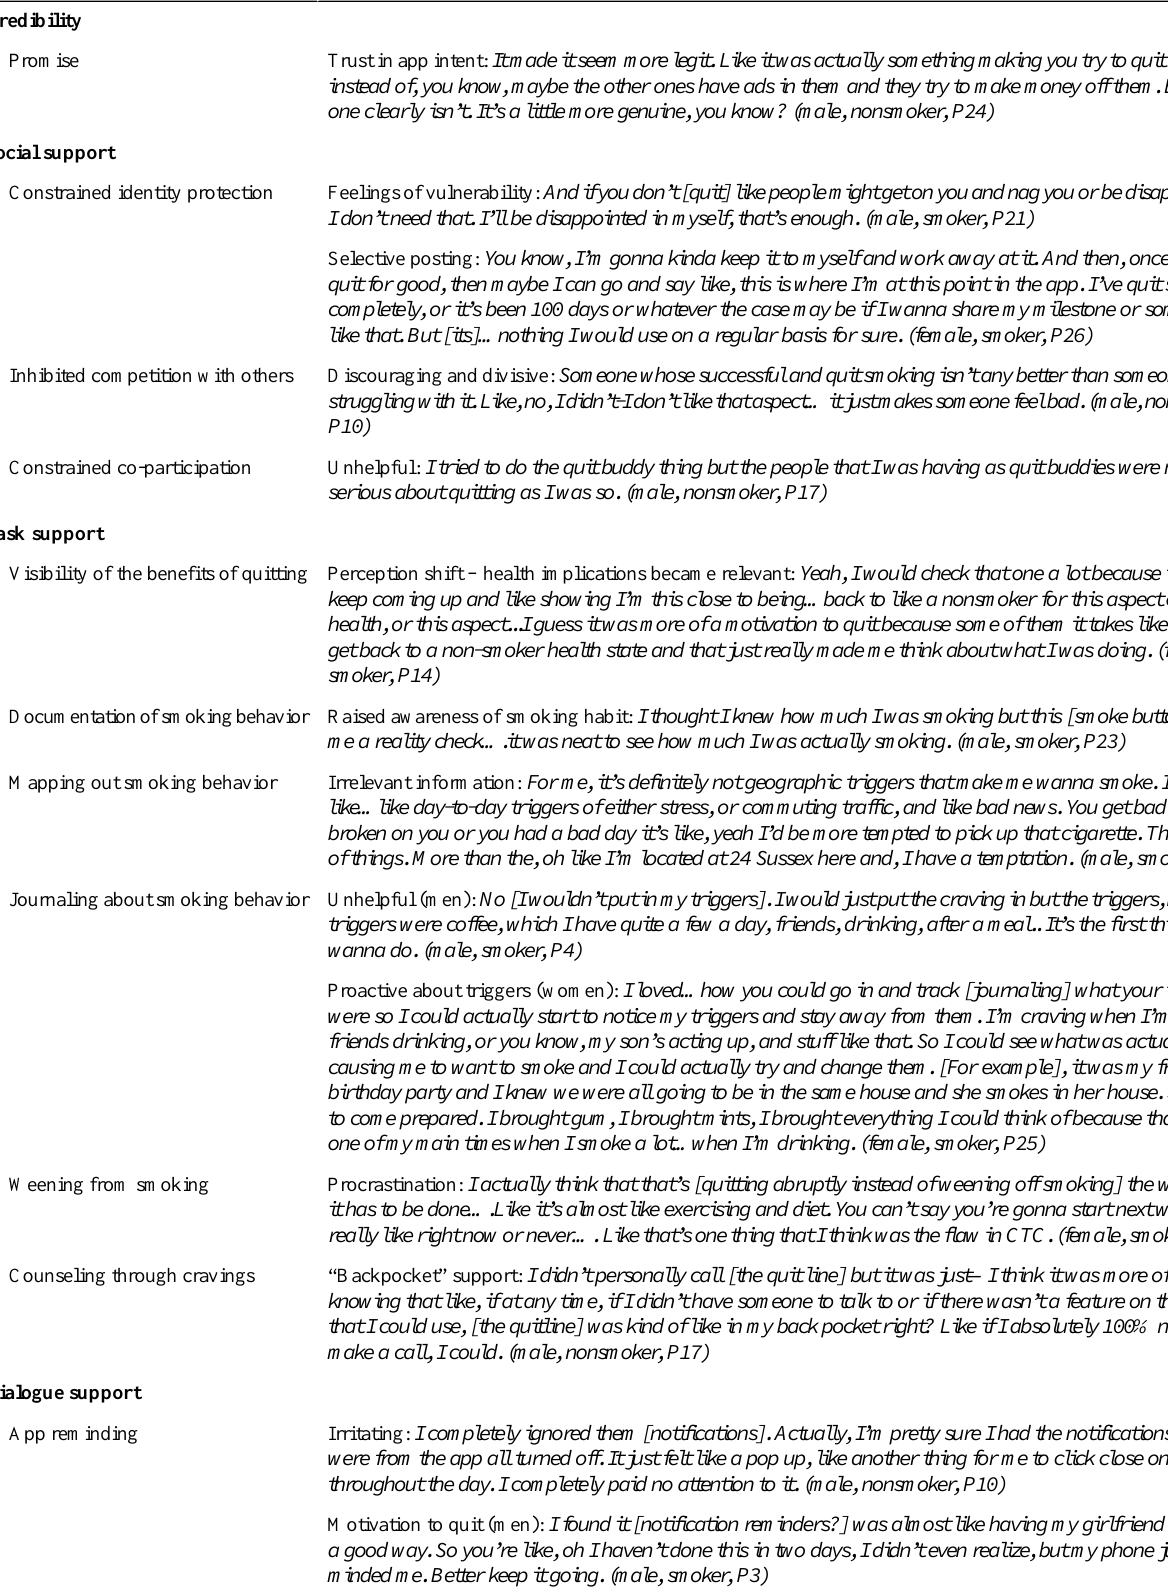
Young adults’experiences and practicesDesign component and affordance